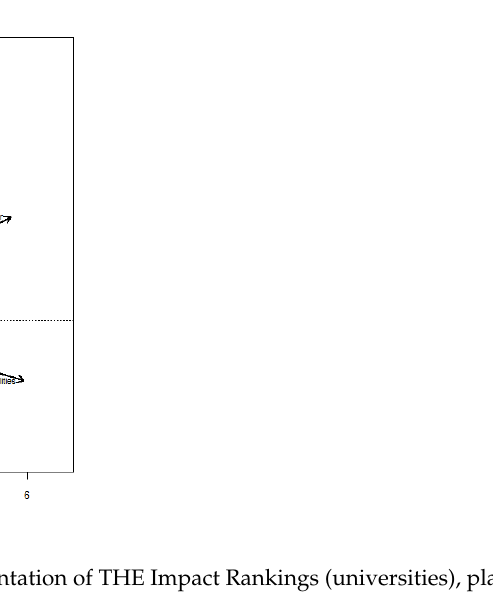
Figure 3. Dynamic biplot factorial representation of THE Impact Rankings (indicators) plane 1–2.